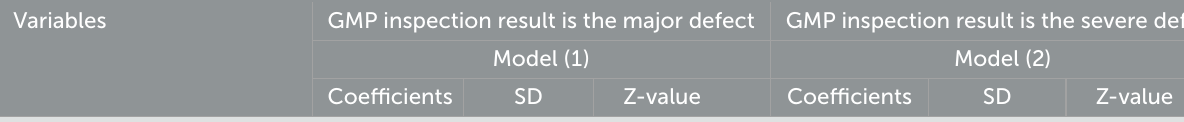
TABLE 5 Multinomial Logit model regression results of factors affecting GMP inspection results of pharmaceutical